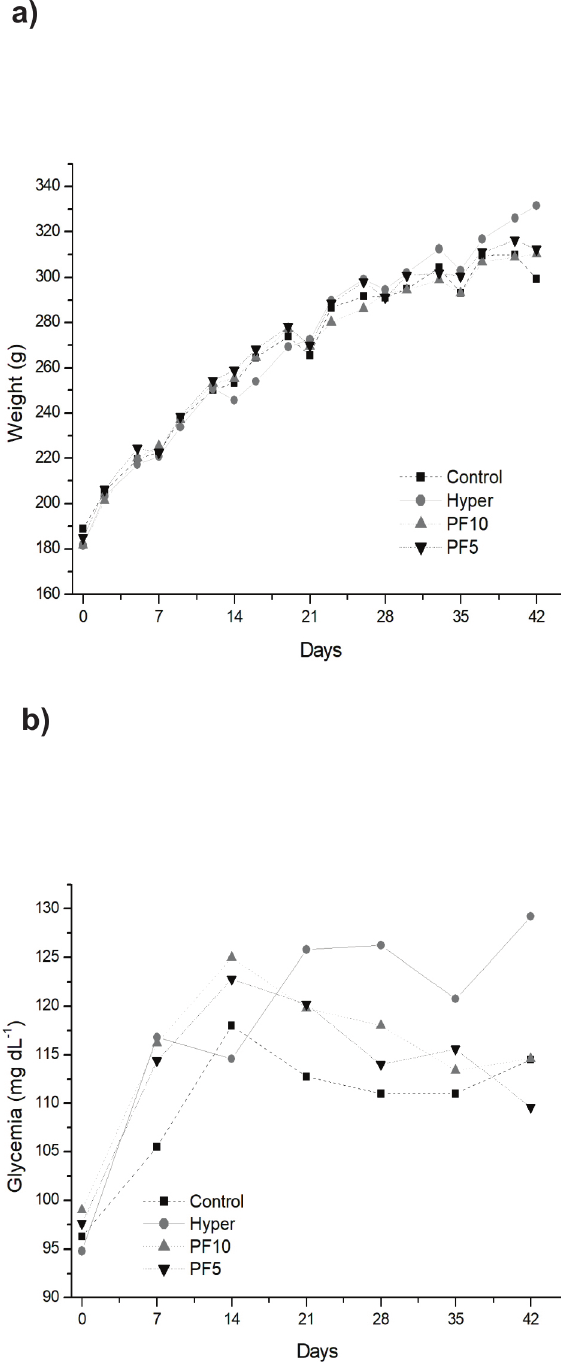
Figure 1 - General characteristics of the animals in the groups: Control (standard diet AIN-93G), Hyper (hypercholesterolemic diet), PF5 (hypercholesterolemic diet + 5% peel flour) and PF10 (hypercholesterolemic diet + 10% peel flour), for a 42 day treatment. ( a ) weight, ( b )